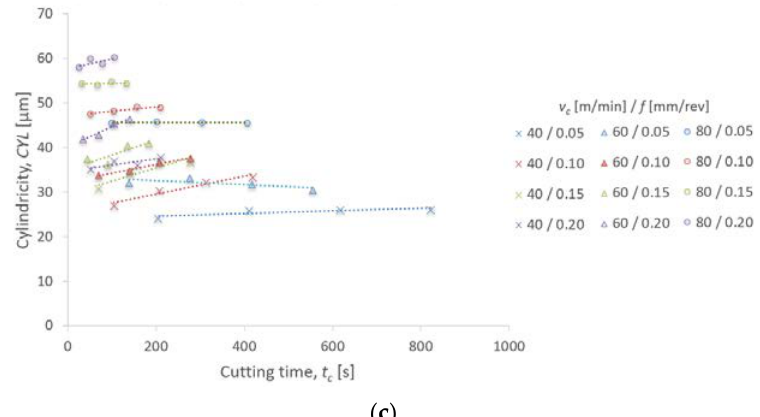
Figure 17. Form deviations evolution as a function of the cutting time and the cutting parameters: ( a ) roundness; ( b ) straightness; ( c ) cylindricity.